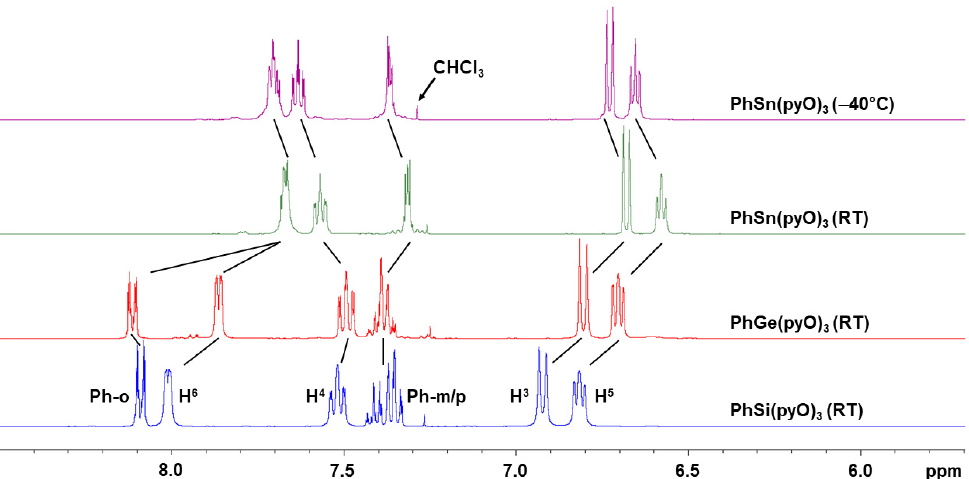
Figure 6. Section of the 1 H NMR spectra of CDCl 3 solutions of (from bottom to top) PhSi(pyO) 3 , PhGe(pyO) 3 , and PhSn(pyO) 3 at room temperature as well as of PhSn(pyO) 3 at − 40 °C. The spectra are internally referenced to SiMe 4 (cf. spectra shown in Figures S1, S4, and S6 in the supplementary material).